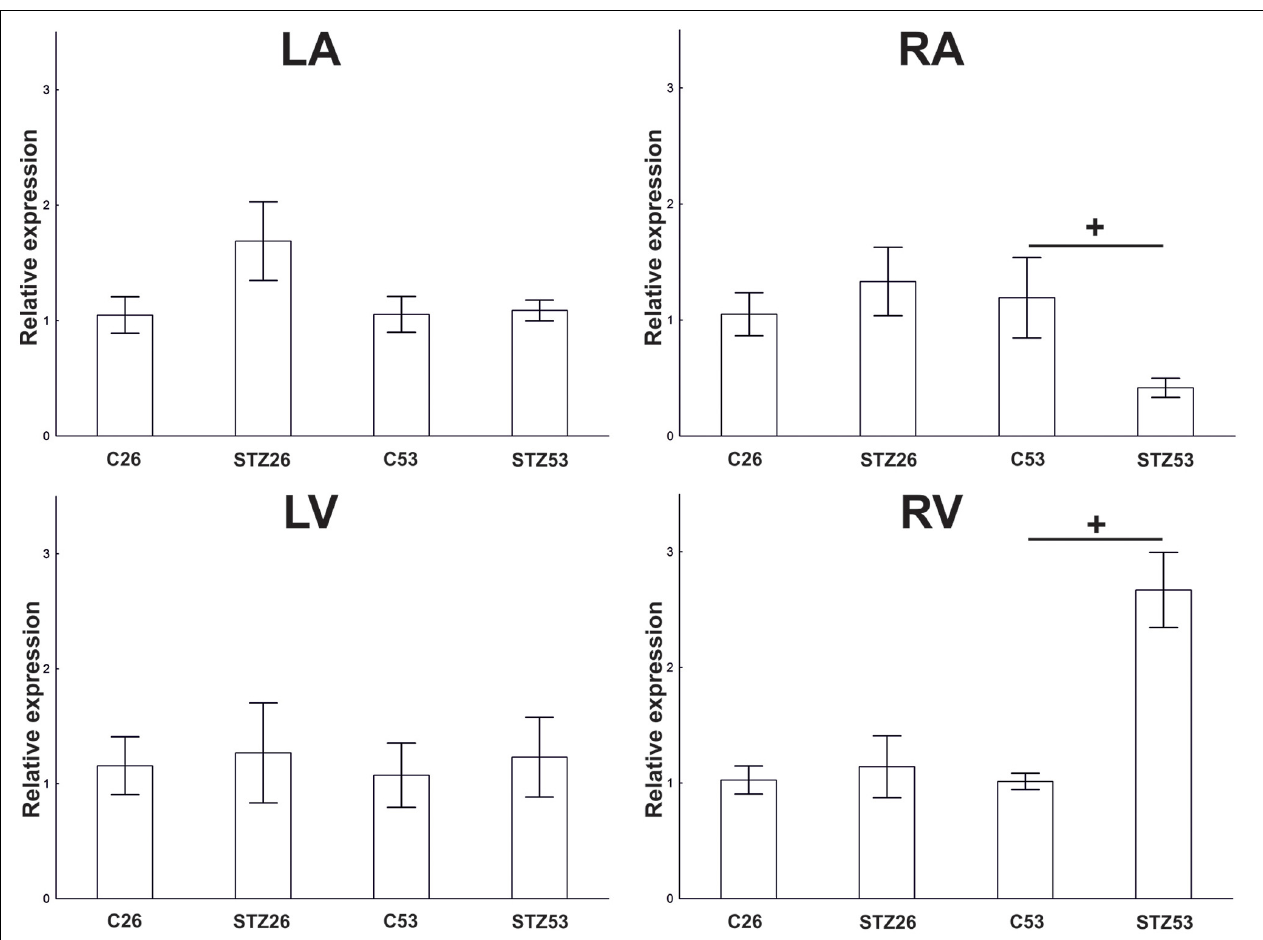
FIGURE 9 | RT-PCR. Effect of STZ treatment on expression of NK1 receptor (NK1R) mRNA 26 and 53 weeks after the application of STZ in separated heart compartments, left atrium (LA), right atrium (RA), left ventricle (LV), and right ventricle (RV). Data are presented as relative expression values (compared to β -actin). Control values of the appropriate heart compartments were used as comparators and were settled as 1. The bars represent the means of the relative expression levels determined for each mRNA with standard errors of the mean. + p <